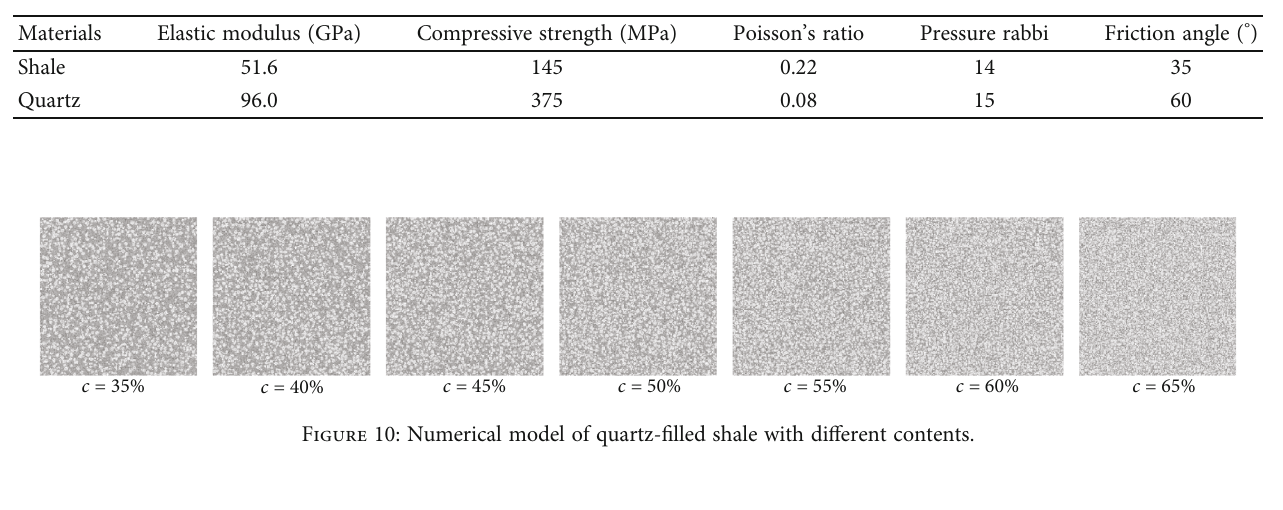
Table 2: Shale mesomaterial unit parameters.